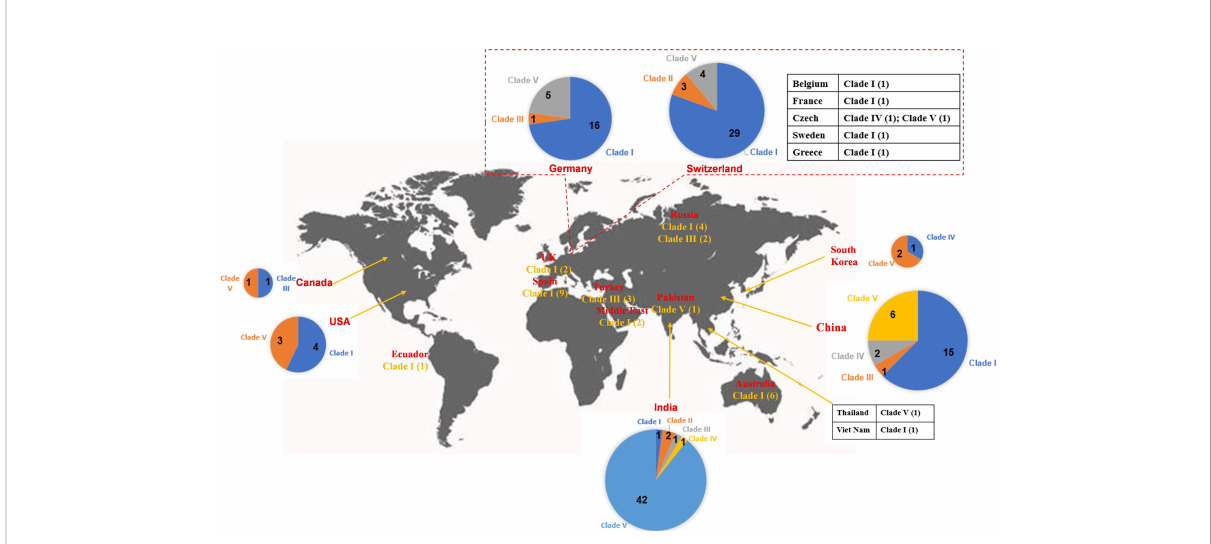
FIGURE 4 Worldwide distribution of bla OXA-48 -like-harboring plasmids in K. pneumoniae . The geographical distribution of the fi ve clades (Clade I – Clade V) from the bla OXA-48 -like-harboring plasmids of K. pneumoniae was calculated and displayed by pie chart, text description, as well as tabular